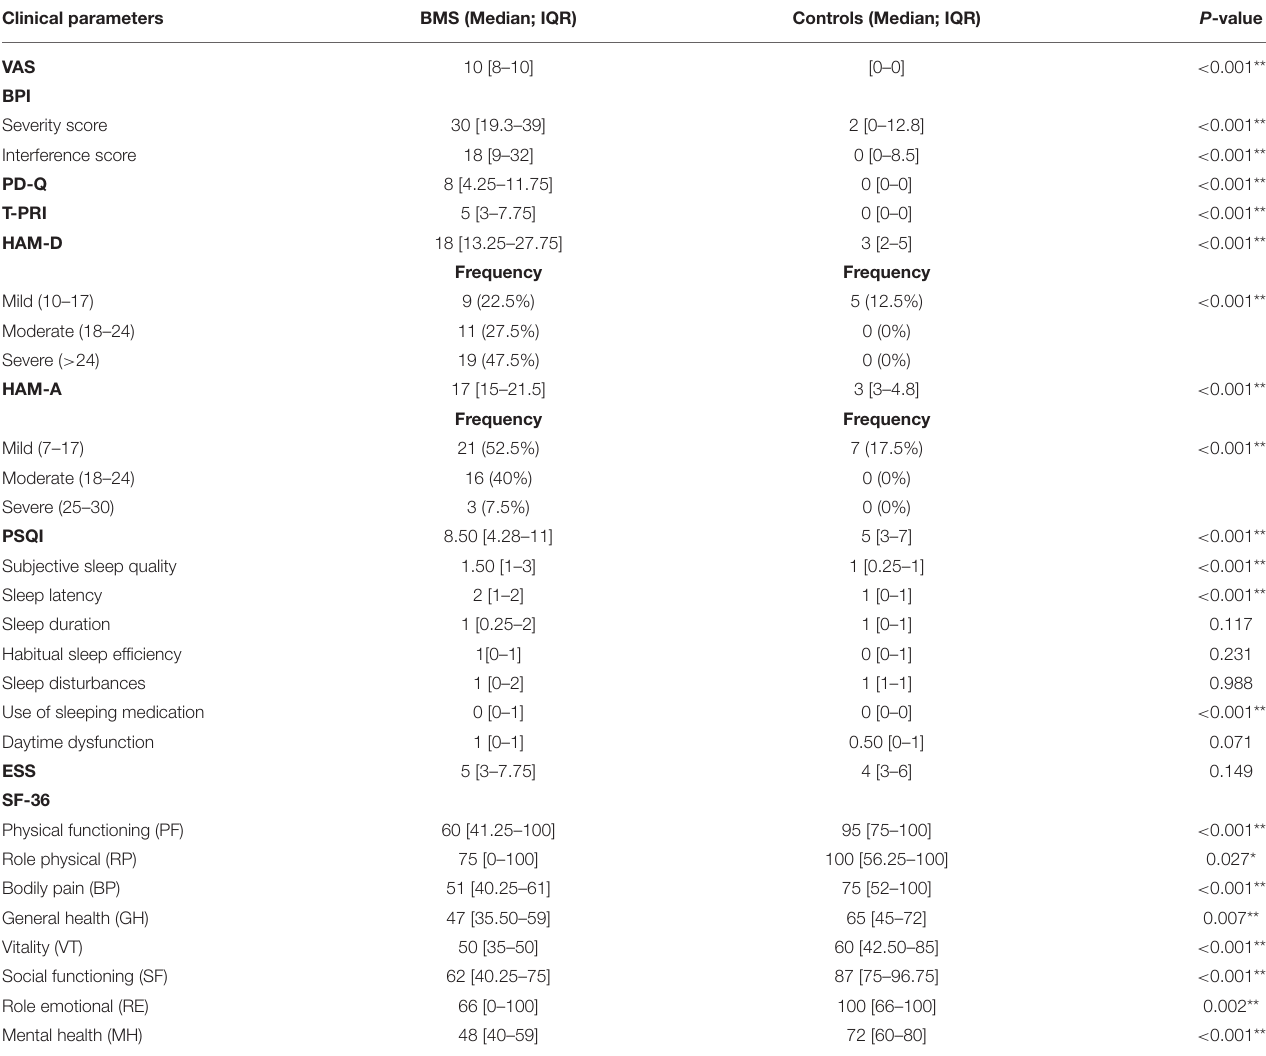
TABLE 6 | Analysis of pain, depression, anxiety, sleep quality, and the quality of life of patients with BMS and control subjects. Clinical